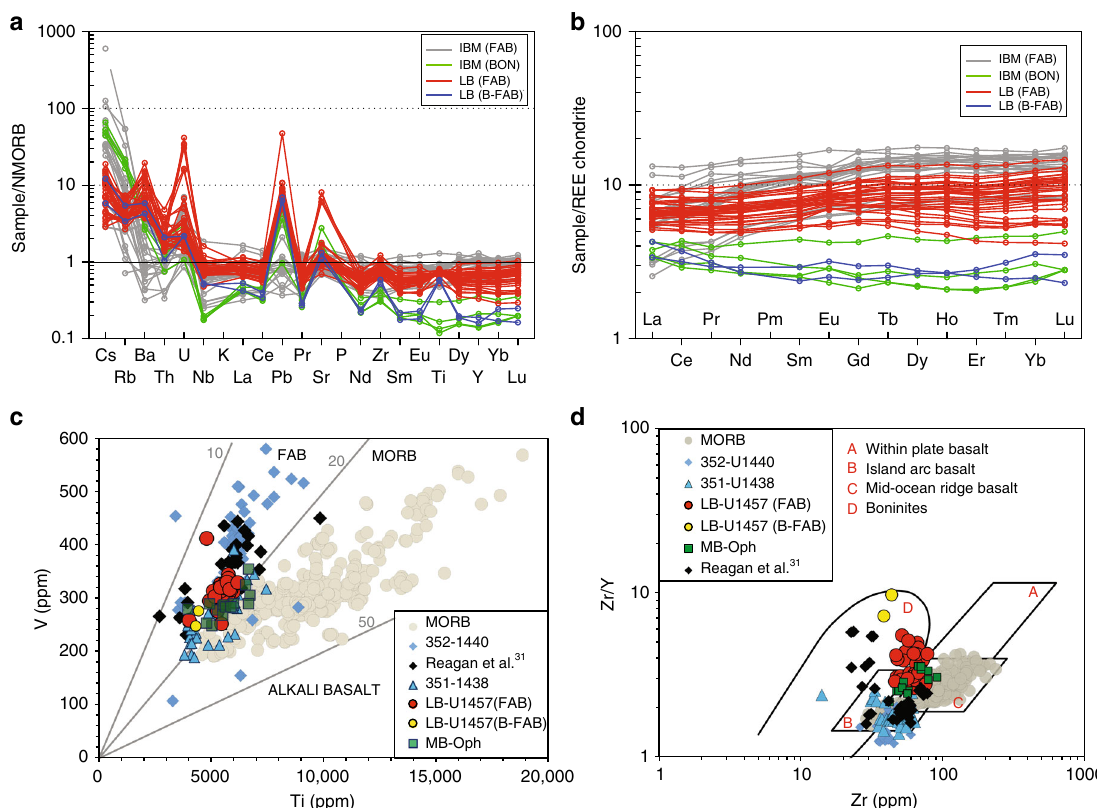
Fig. 3 Geochemical discrimination diagrams of Laxmi basin lavas. Variations in LILEs and HFSEs abundances within the cored igneous section at Site U1457. a N-MORB normalised plot 53 . b Chondrite-normalised REE diagram 54 showing compositions of Site U1457 lava. c Ti vs. V discrimination diagram 38 showing Site U1457 lava compositions. Data sources for comparisons: Muslim Bagh-Bela ophiolites 43 – 46 , MORB 29,30 , 351 32 , 352 36 . d Zr vs. Zr/Y diagram 66,67,70 for the Site U1457 lava. Most of the LB basalts fall into the arc and boninites fi elds. IBM Izu – Bonin Mariana, FAB forearc basalt, B-FAB boninitic forearc basalt, MB-Oph Muslim Bagh